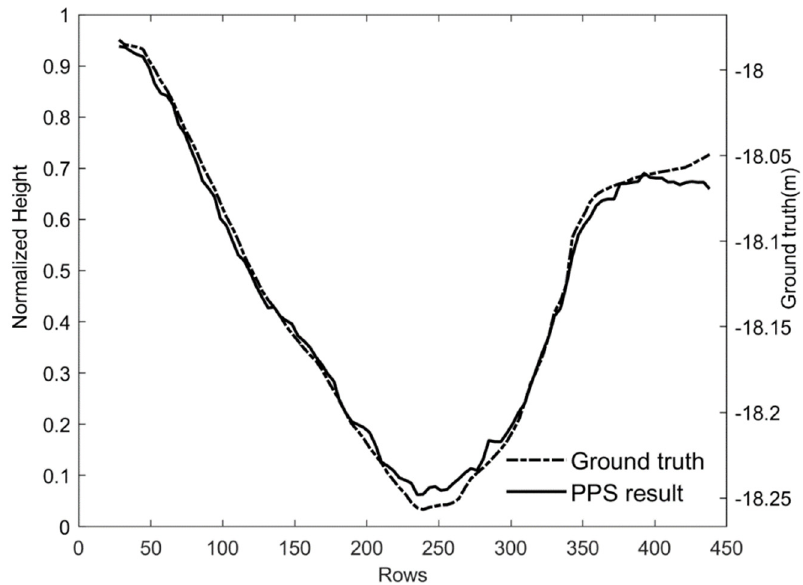
Figure 10. Height profile of ROI 2 in simulated imagery.